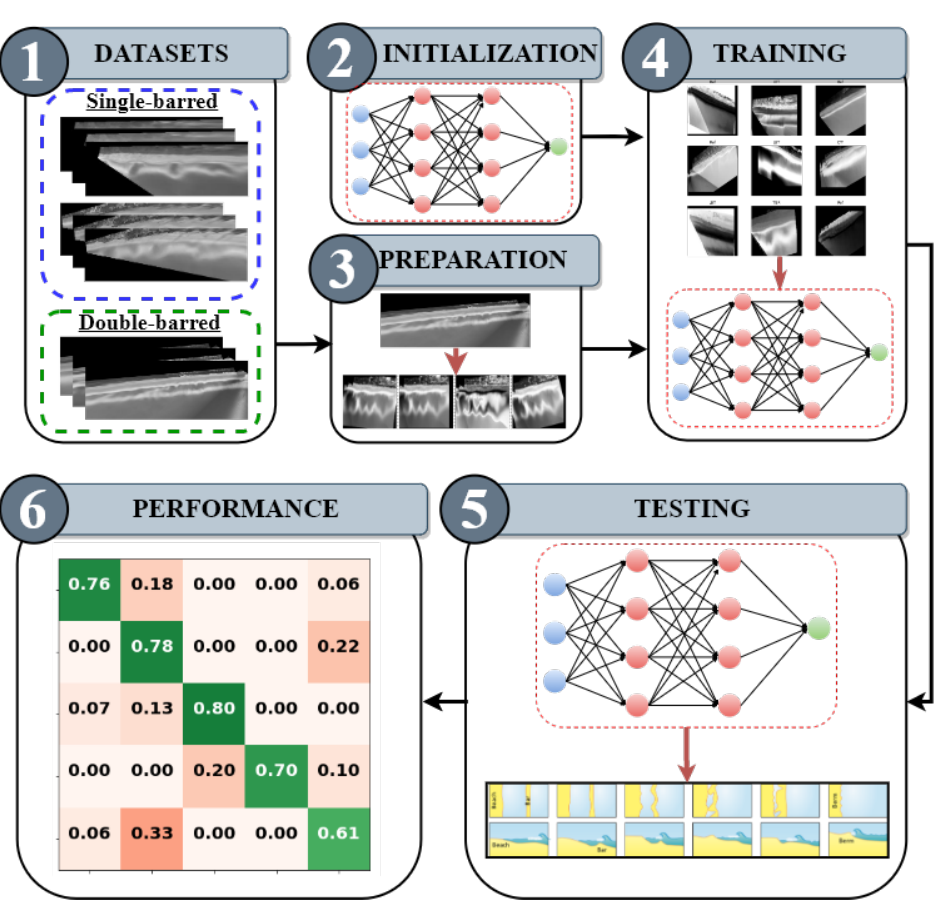
Figure 4. Schematic block diagram of the step-by-step